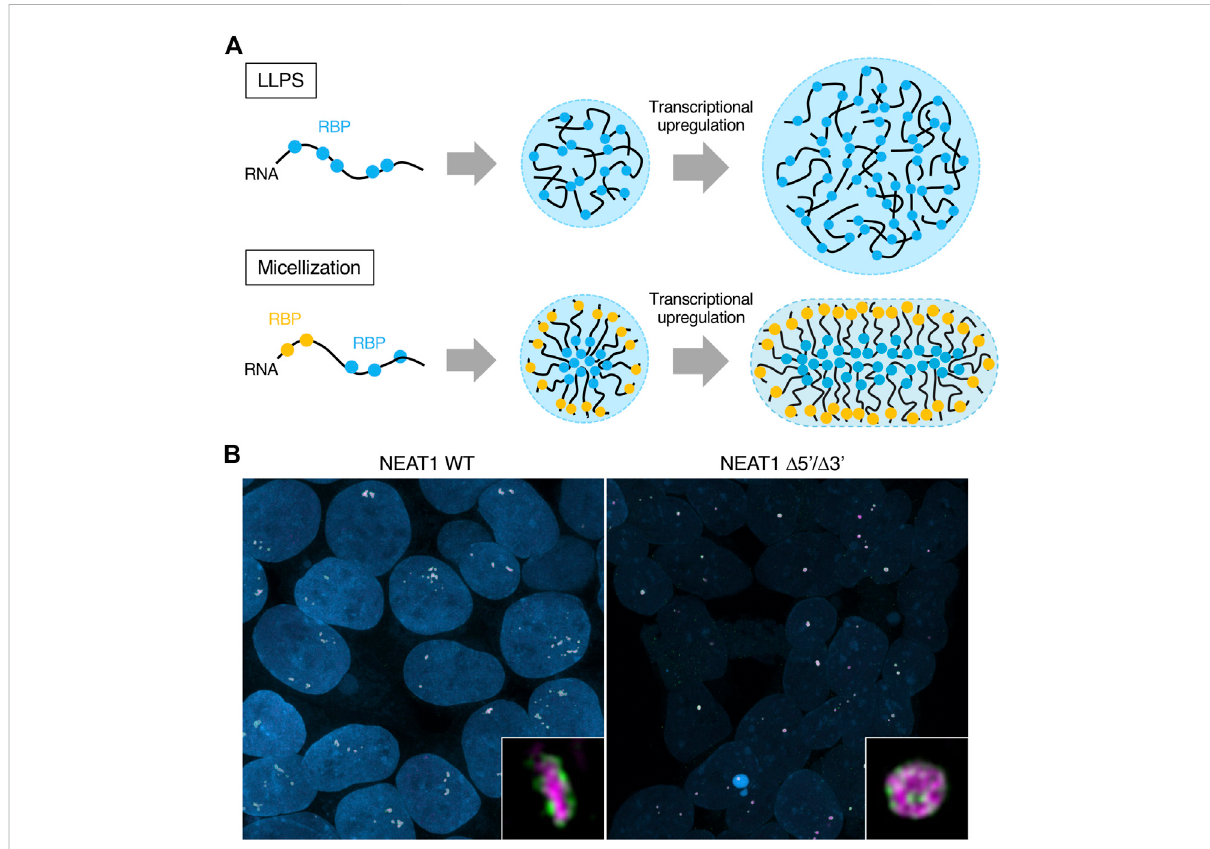
FIGURE 5 Differences of the condensates formed by liquid-liquid phase separation LLPS and micellization. (A) Schematics show condensates formed by LLPSandmicellization.Theirinternalmorphologiesandbehaviorsupontranscriptionalupregulationarealsoshown. DifferentRNA-binding proteins (RBPs) are illustrated as other color circles (blue and yellow). The condensates formed by LLPS and micellization can contain many types of RBPs, although the illustration shows one or two types of RBPs for simplicity. (B) Representative images of the paraspeckles in HAP1 NEAT1 wild type (WT) and Δ 5 ’ / Δ 3 ′ cell lines are shown. Insets are magni fi ed images of the paraspeckles in these cell lines. The 5 ′ domains of NEAT1_2 are shown in green and the middle domains of NEAT1_2 are shown in magenta. Nuclei are shown in